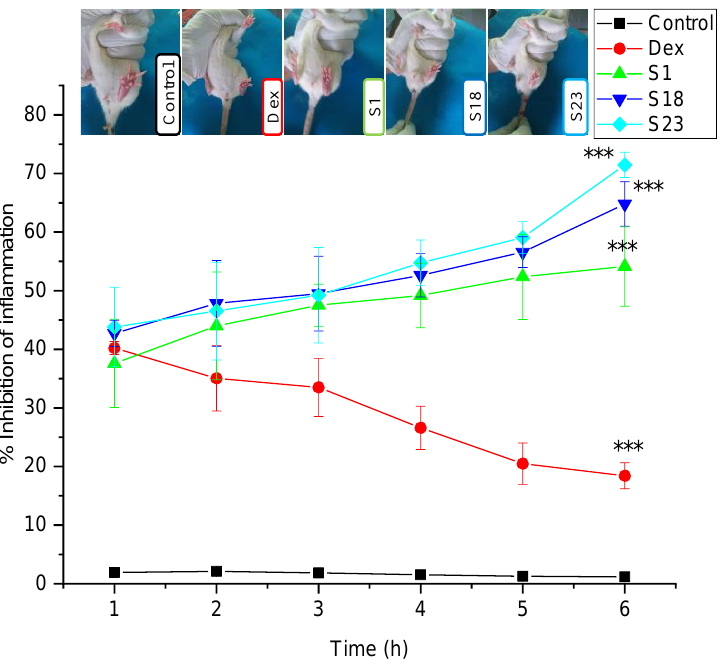
Figure 10. Photographs of rat paw edema after 6 h and percentage inhibition of carrageenan-induced paw edema in rats. The error bar designates the standard deviation (n = 3). Here, the control refers to the diseased group, which did not receive any treatment. Here, level of significance was slightly significant (* p < 0.05), moderately significant (** p < 0.01) and highly significant (*** p < 0.001) for all treatment groups when compared with control group.